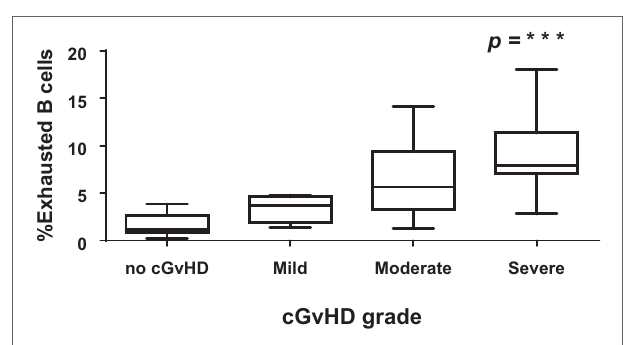
FigUre 6 | CD21 − CD27 − CD10 − B cells and severity of chronic graft- versus-host disease (cGvHD). Box plot depict the severity of cGvHD (moderate to severe) according to CD21 − B cell frequencies in 32 patients with cGVHD.